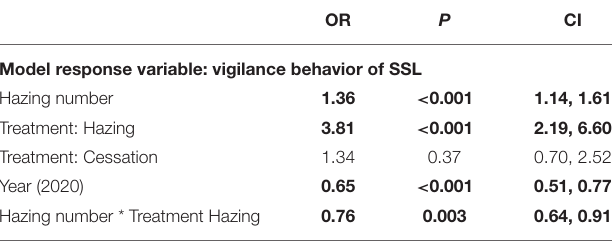
TABLE 5 | Model estimates of the ordinal logistic regression model for factors predicting Vigilance